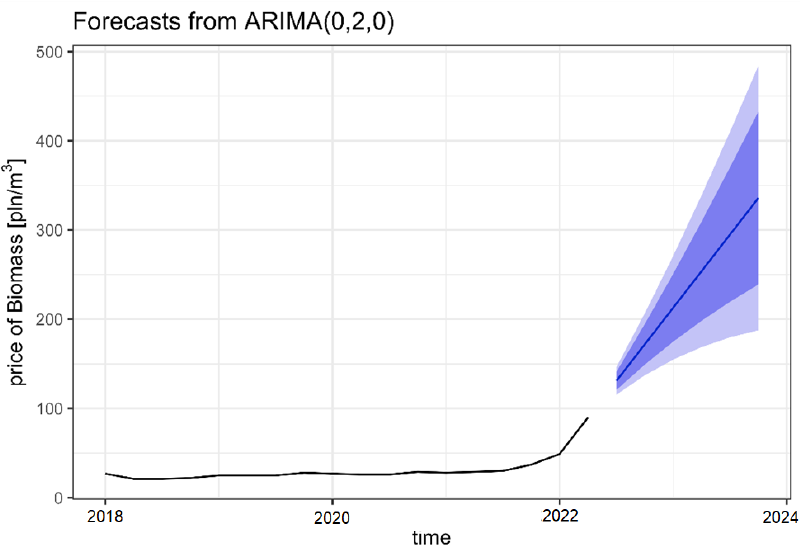
Figure 3. Price forecast for the M2 ZE assortment for Q3 of 2022, Q4 of 2022, and Q1 of 2023. Source: Own elaboration based on data obtained from the State Forests IT System (SILP).